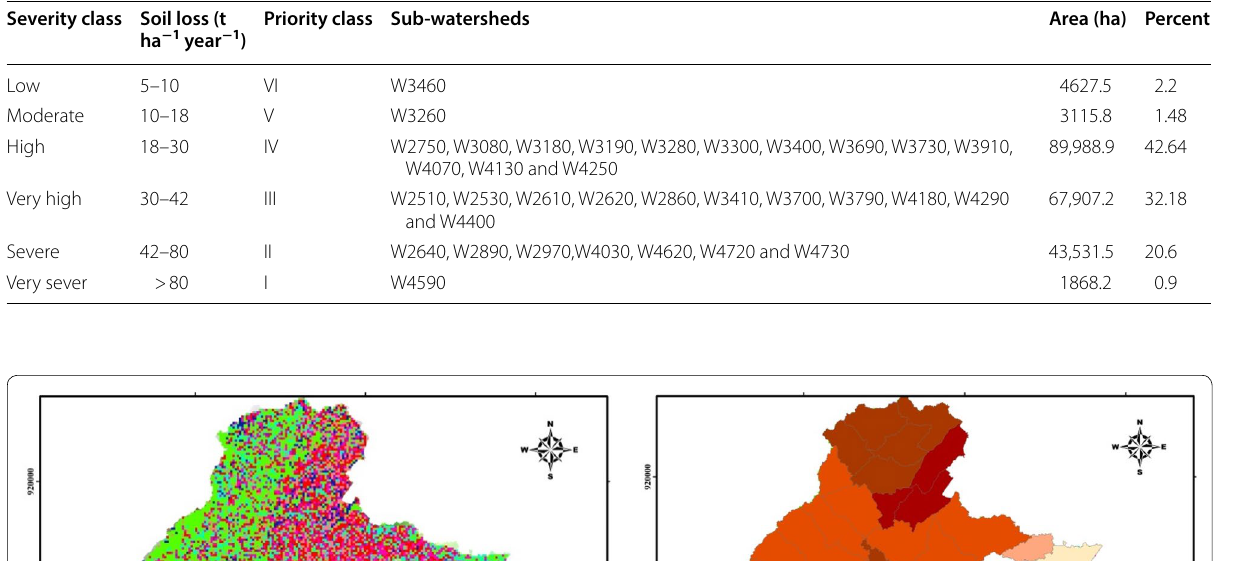
Table 10 Annual soil loss rate and severity class